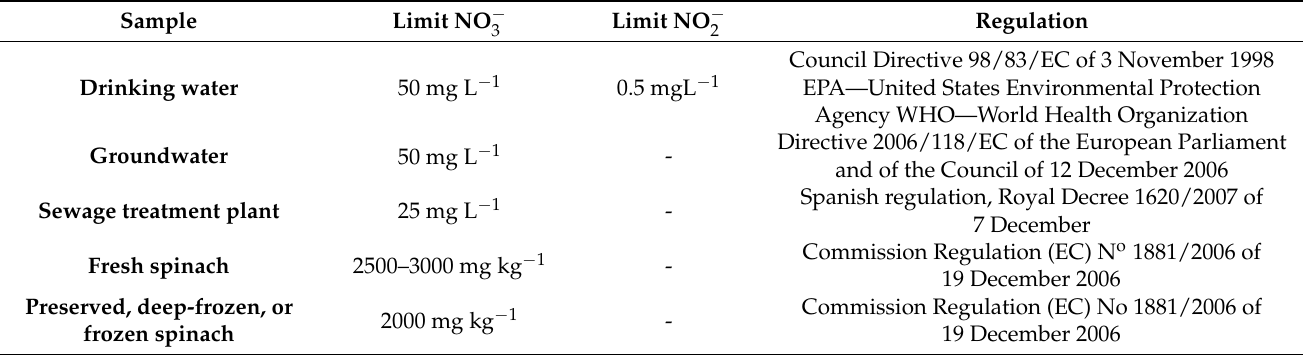
Table 1. Concentrations limits of nitrate or nitrite established by different